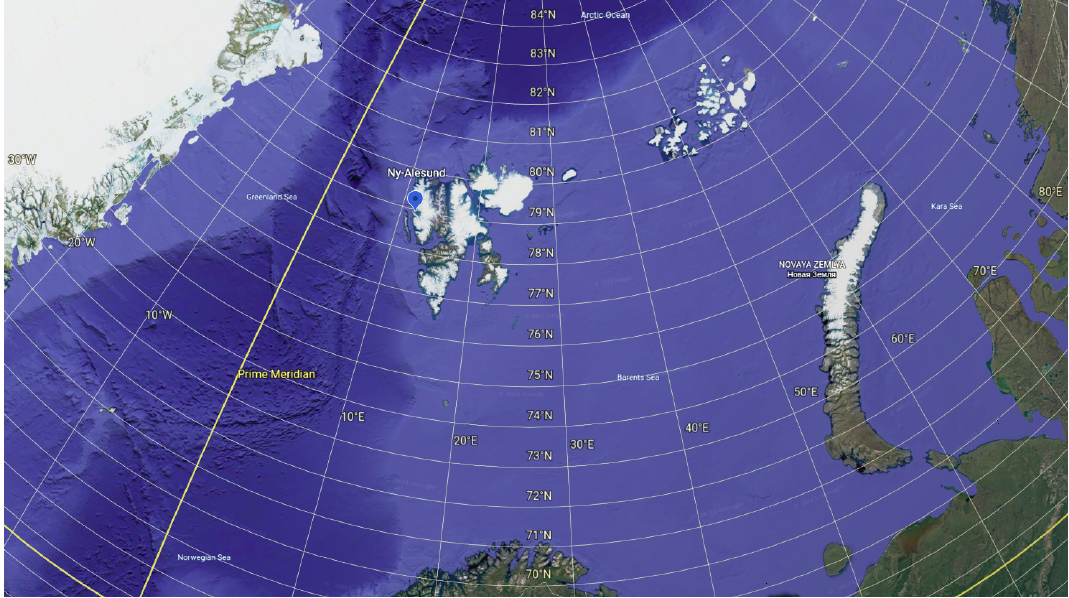
Figure 1. Map of the European Arctic. The site of Ny- Ålesund, which is located on the west coast of the Spitsbergen island, Svalbard archipelago, is indicated on the map. The map was produced with Google